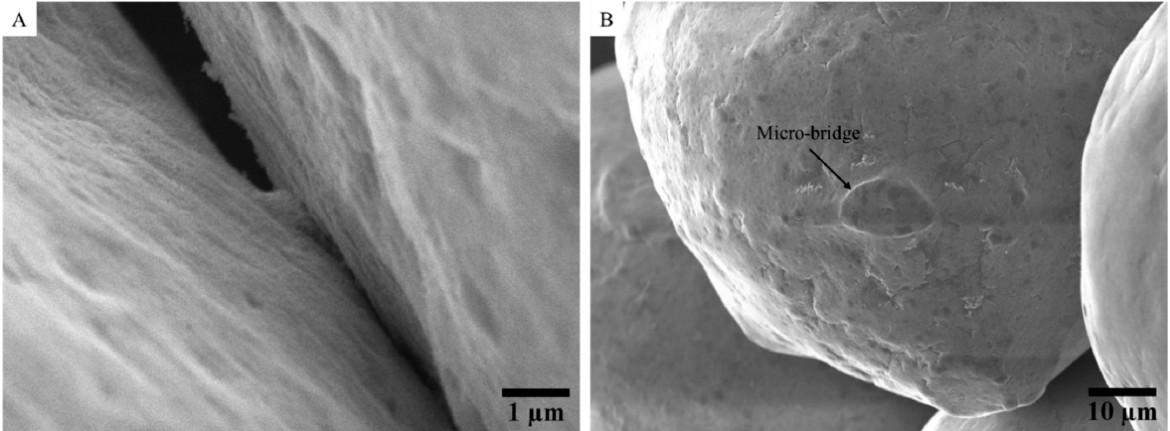
Figure 6. SEM observations of the raw powder after application of a DC current up to 1 A (stages 3 − 4 ): ( A ) clusters of copper particles; ( B ) micro-bridges at interparticles’ contacts areas.